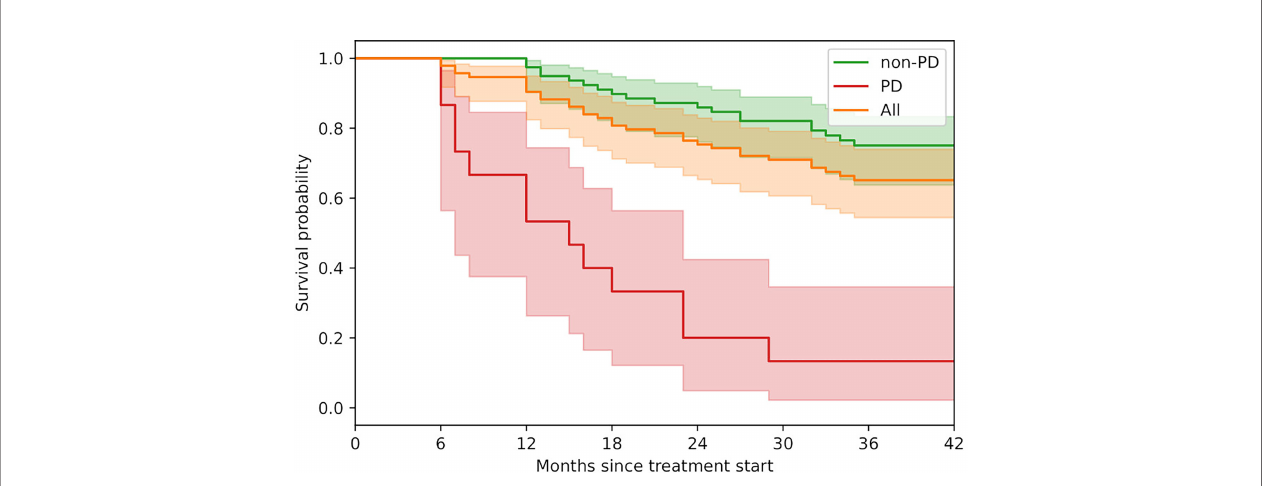
FIGURE 1 | Kaplan-Meier survival curves. Progressive patients (PD; n=15) include iPD and iUPD. Non-progressive patients (non-PD; n=79) include iCR, iPR and iSD. Shaded areas represent the 95% con fi dence